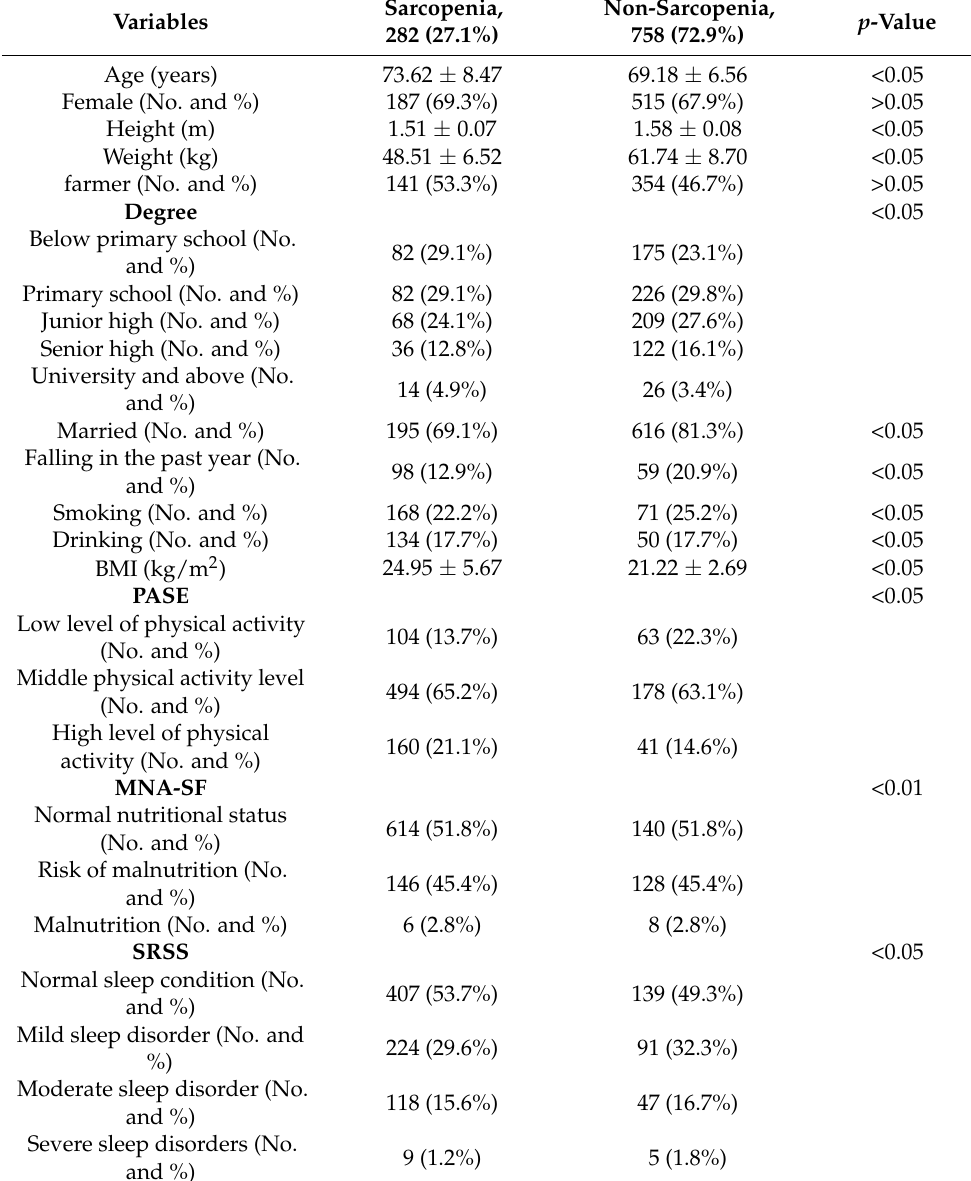
Table 1. Characteristics of older adults with or without